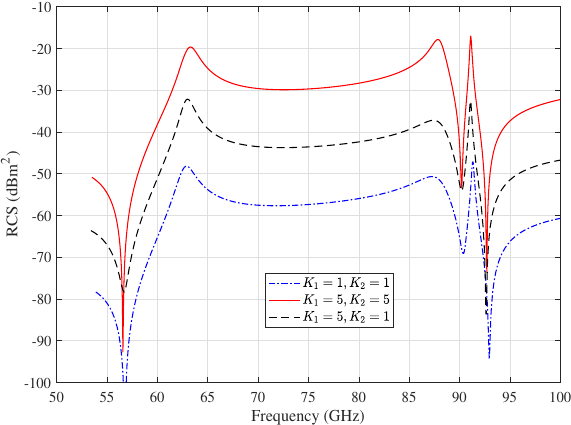
Figure 3. Monostatic RCS of DR array for different planar DR array